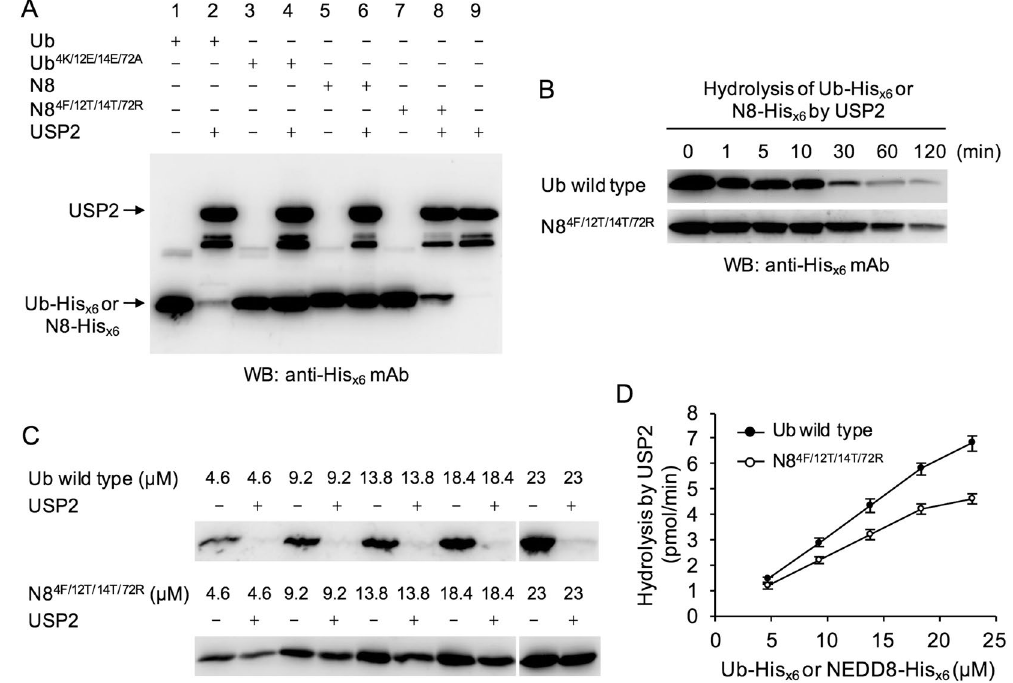
Figure 5. Comparison of the reaction kinetics of Ub and NEDD8 4F/12T/14T/72R catalyzed by USP2. ( A ) Ub, Ub 4K/12E/14E/72A , NEDD8, and NEDD8 4F/12T/14T/72R (13.8 μ M) were incubated with or without USP2 (4.75 μ M) at 37 °C for 60 min. All reactions were terminated by adding 4X SDS-PAGE sample buffer and incubating at 100 °C for 10 min. Samples were separated on 16.6% SDS-PAGE and further analyzed using western blotting with the anti-His x6 tag antibody. ( B ) In order to measure the reaction kinetics of Ub and NEDD8 4F/12T/14T/72R catalyzed by USP2, Ub or NEDD8 4F/12T/14T/72R (13.8 μ M) was incubated with USP2 (4.75 μ M) to perform a time- course experiment for 120 min. At each time point, reactions were terminated by adding 4X SDS-PAGE sample buffer and incubating at 100 °C for 10 min. All of collected samples were separated on 16.6% SDS-PAGE and further analyzed using western blotting with the anti-His x6 tag antibody. The full-length blots are presented in Supplementary Figure S4. ( C ) To perform a standard curve calibration which can determine the linear reaction range, the various amounts of Ub-His x6 and NEDD8 4F/12T/14T/72R -His x6 (4.6, 9.2, 13.8, 18.4, and 23 μ M) were incubated with USP2 (4.75 μ M) to conduct the same experimental protocol as described in ( A ). Data are representative of three independent experiments. The full-length blots are presented in Supplementary Figure S5. ( D ) The signal intensity of the unprocessed His-tagged substrates from three independent experiments was measured by a densitometer and processed by ImageJ. The reaction rates were calculated according to the His- tagged substrates which were hydrolyzed by USP2 and further plotted against the substrate concentrations used in the indicated reactions. Values are means ± S.D., n =